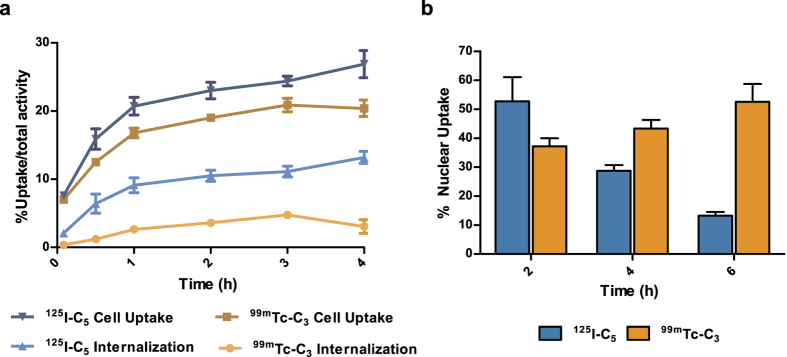
Cellular and nuclear uptake of125I-C5and 99mTc-C3 in PC3 cells: (a) Cellular uptake and internalization. The total activity associated with the cell (cellular uptake) as well as the intracellular activity (internalized) expressed as a percentage of total activity applied. (b) Nuclear uptake expressed as a percentage of cell-associated activity.